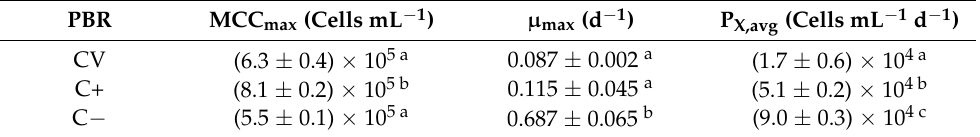
Table 2. Growth parameters determined for each PBR: CV ( C. vulgaris + UWW), C+ ( C. vulgaris + autoclaved UWW), and C − (raw UWW). Values with a common superscript letter and within the same column are not statistically different ( p >